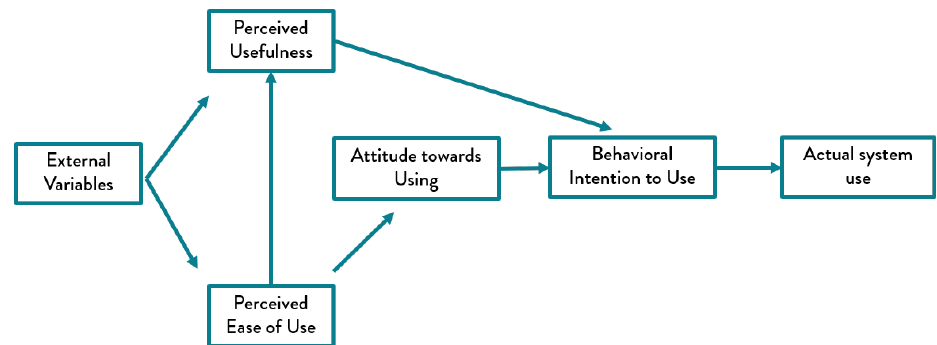
Figure 1. Technology Acceptance Model